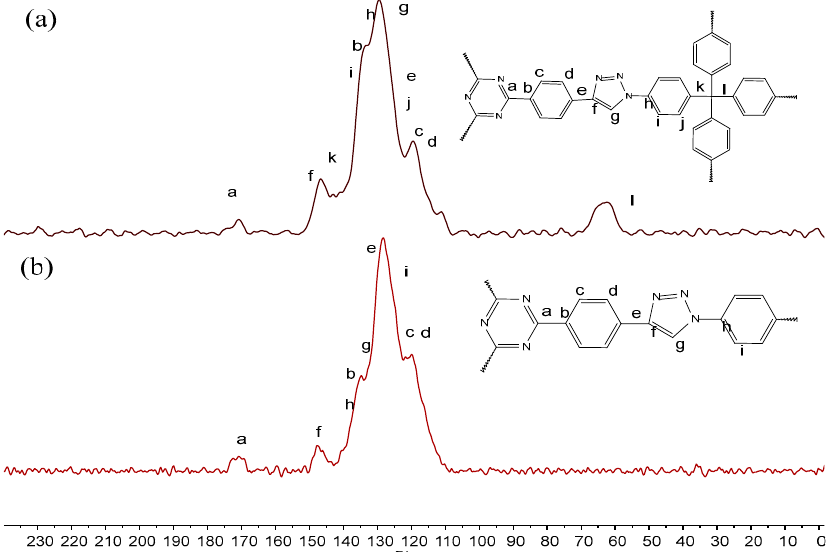
Figure 2. Solid-state 13 C CP/MAS NMR spectra of: ( a ) NPOP-1, and ( b )